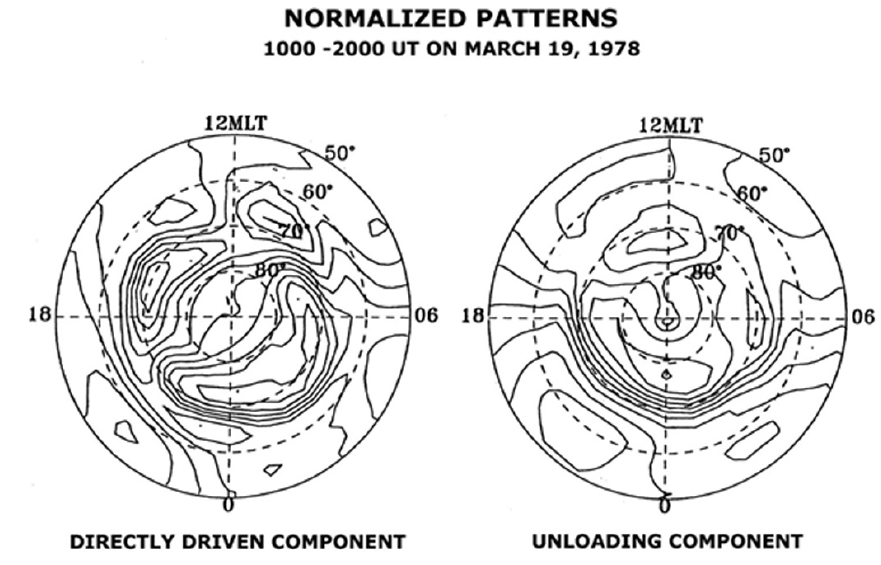
Fig. 9b. The equipotential pattern of the directly driven current (left) and the unloading current (right); see Sun et al. (1998).